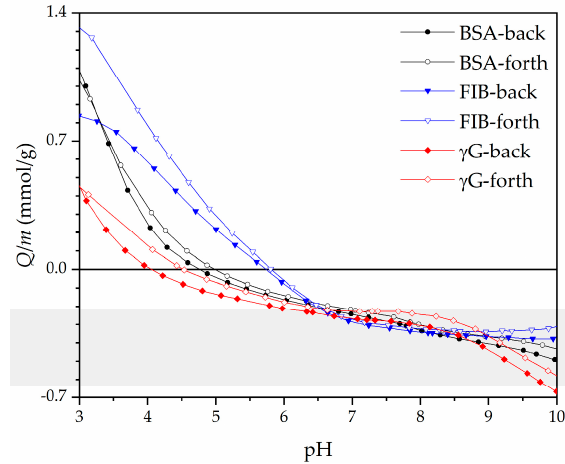
Figure 9. Potentiometric titration of BSA, FIB and γ G [35].